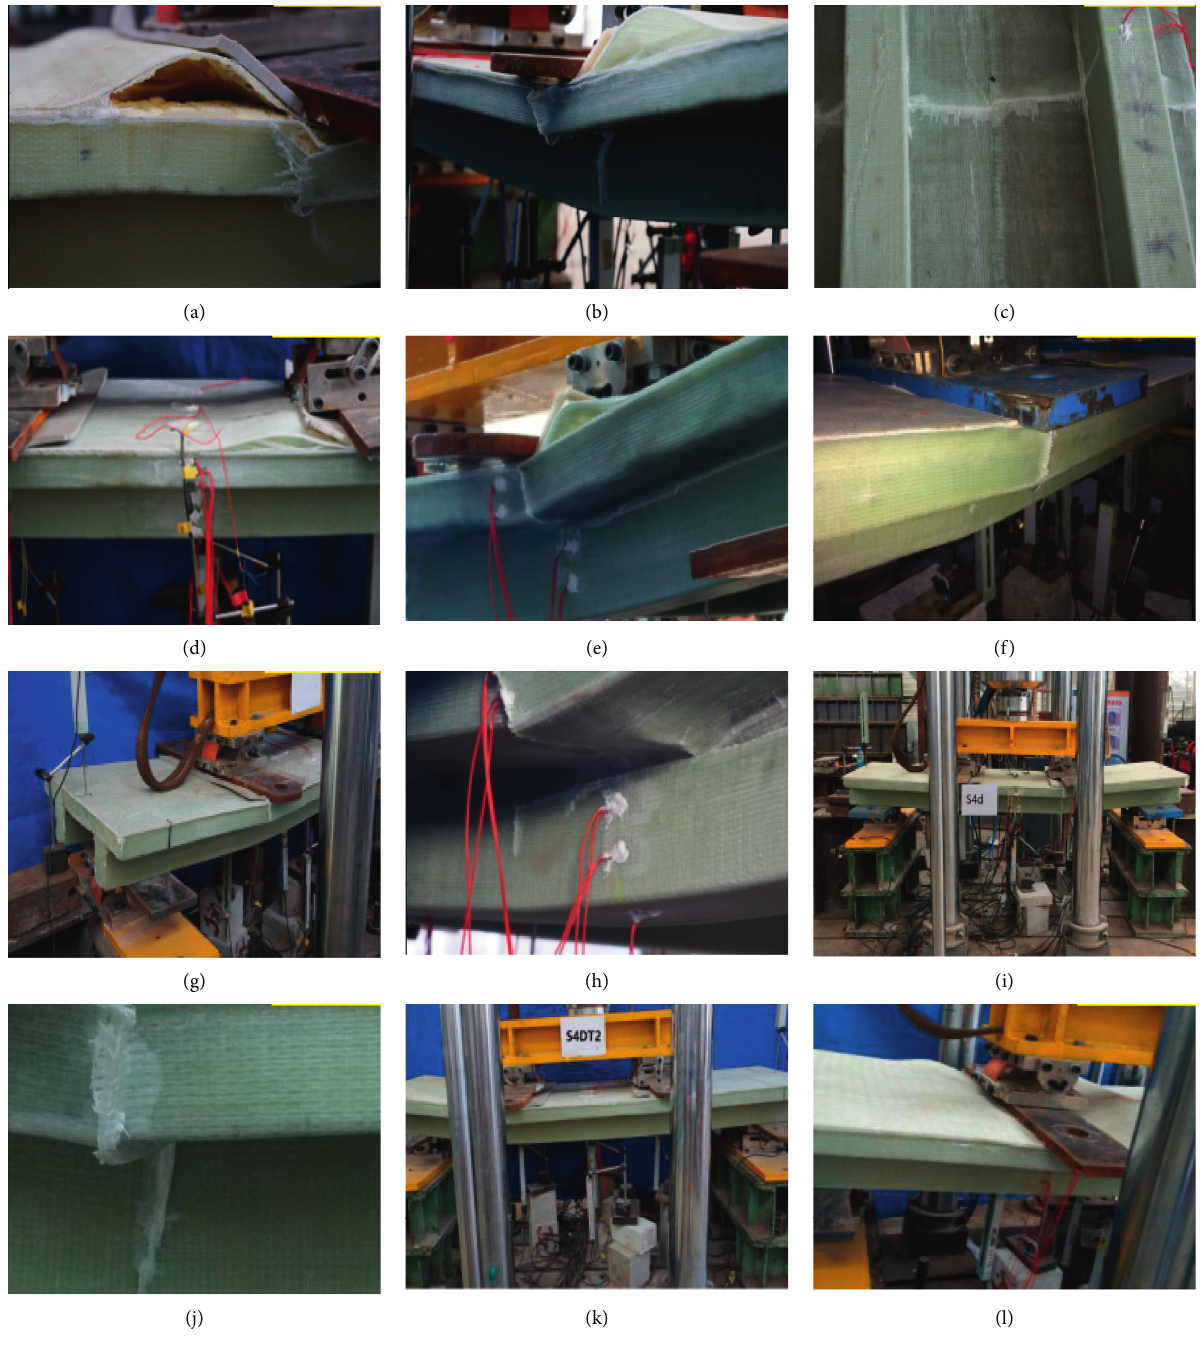
Figure 5: Failure modes. (a) S2D. (b) S4D. (c) S4D. (d) S6D. (e) S4DH. (f) S4DV. (g) S4DVH. (h) S4DV. (i) S4d. (j) S4d. (k) S4DT2. (l)